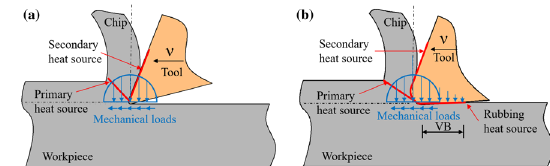
Figure 20 Schematics of cutting process of a new and b worn cutting